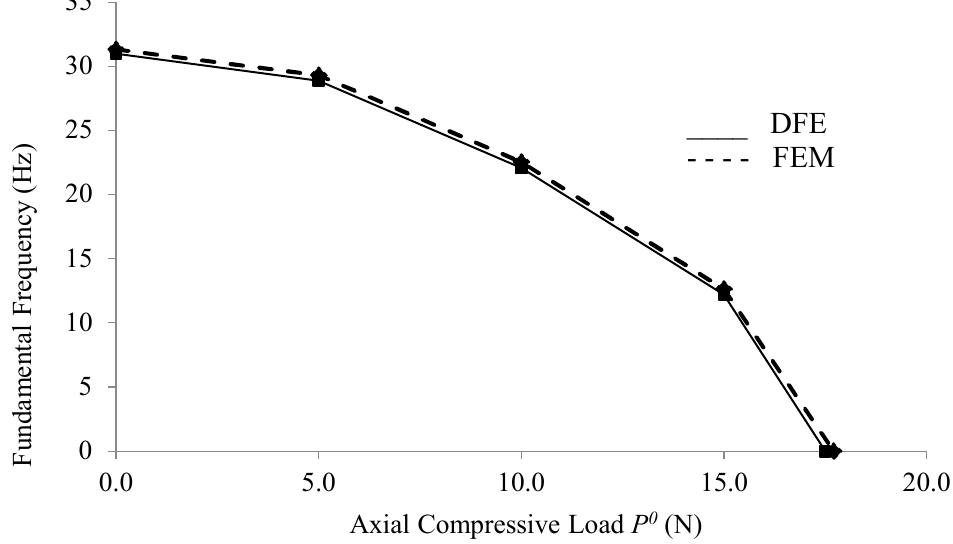
Figure 10. Variation of the fundamental natural frequency vs. axial compressive force for the cantilevered, three-layer glass–epoxy and aluminum sandwich beam (GLARE), obtained using the five-element DFE and FEM models, with M zz = 20 N.m.